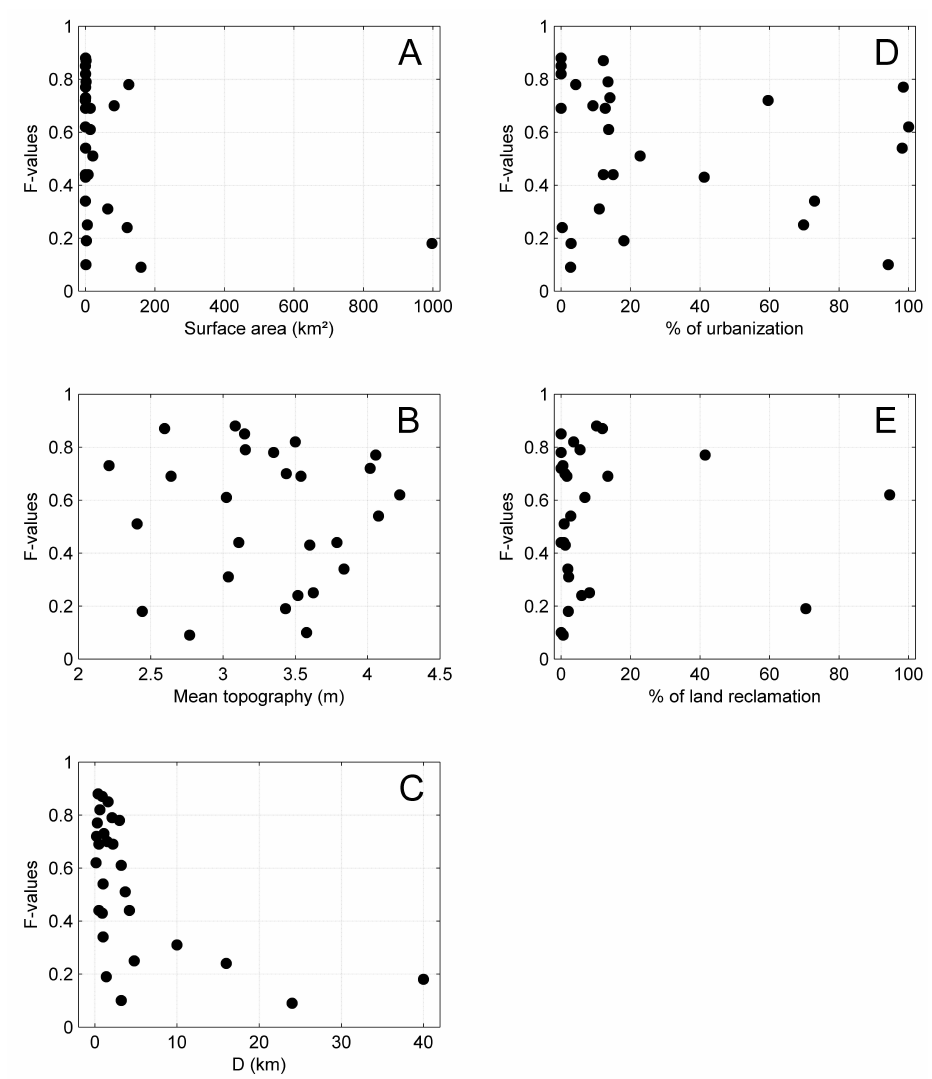
Fig. 4. F-values computed using method SM2 for the 27 marshes regarding: (A) surface area, (B) mean topography, (C) distance between the coastline and the landward boundary of the marsh (D) , (D) , urbanization rate, (E) land reclamation rate. Table 6. Results of fit measurements computation for Brouage and Poitevin marshes, using method SO and best F-values using methods SM1and SM2. Marsh